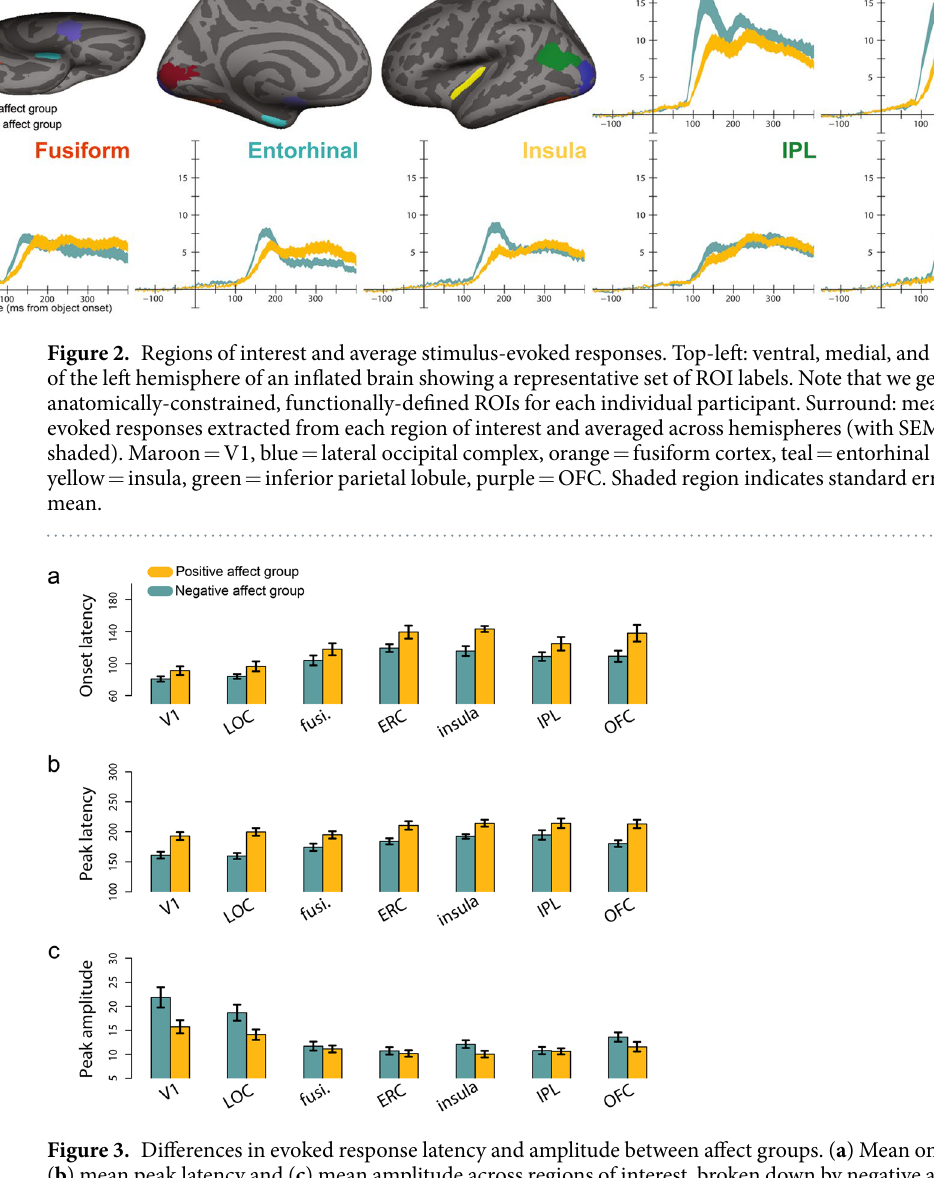
Figure 3. Differences in evoked response latency and amplitude between affect groups. ( a ) Mean onset latency ( b ) mean peak latency and ( c ) mean amplitude across regions of interest, broken down by negative and positive affect group. LOC = lateral occipital complex, fusi. = fusiform cortex, ERC = entorhinal cortex, IPL = inferior parietal lobule, OFC = orbitofrontal cortex. Error bars indicate standard error of the